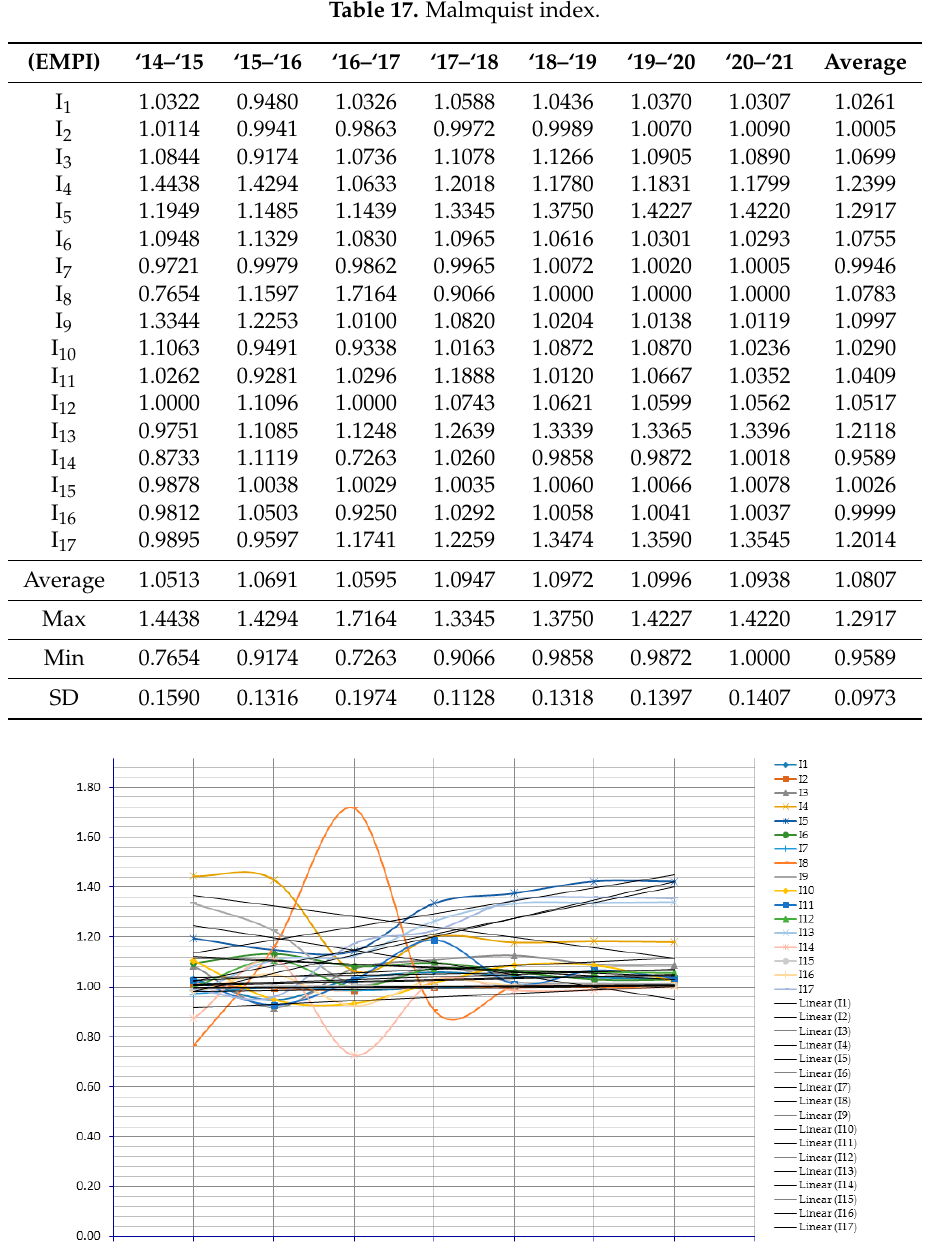
Figure 5. Malmquist index.